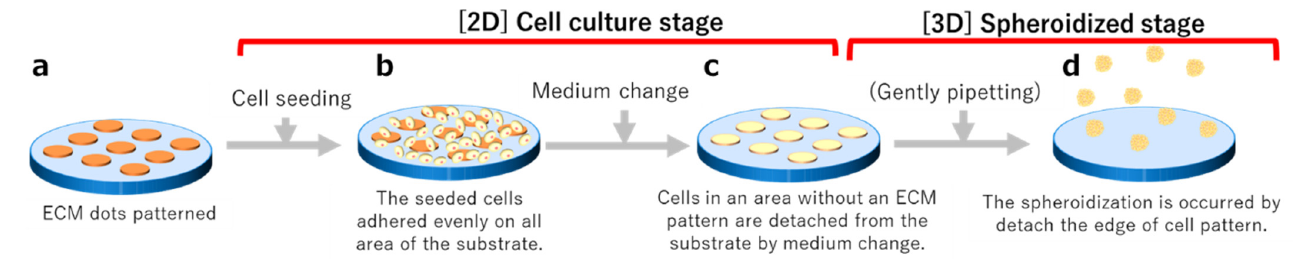
Figure 2. Schematic diagram of the spheroid production process. ( a ) Matrix transferred via stamping. ( b ) Cell adhesion occurs one day after seeding. ( c ) Cell colony formation a few days after seeding. ( d ) After cell detachment, spheroids form in suspension.